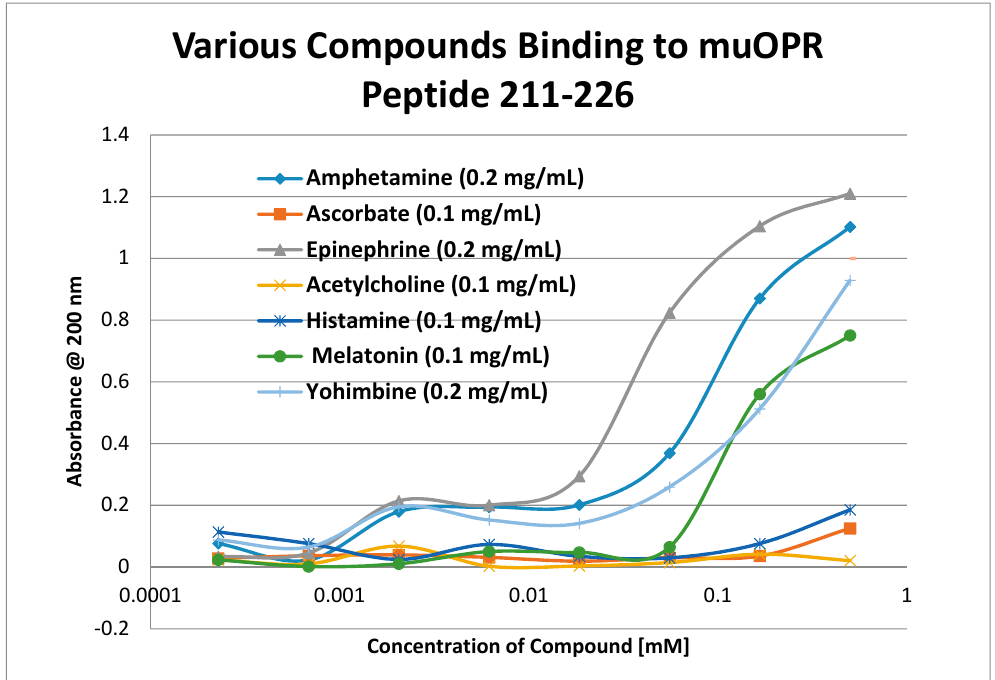
Figure 4. UV spectroscopic study of epinephrine binding to mu opioid receptor (muOPR) peptides derived from the extracellular loop and adjacent transmembrane regions (see Figure 1).